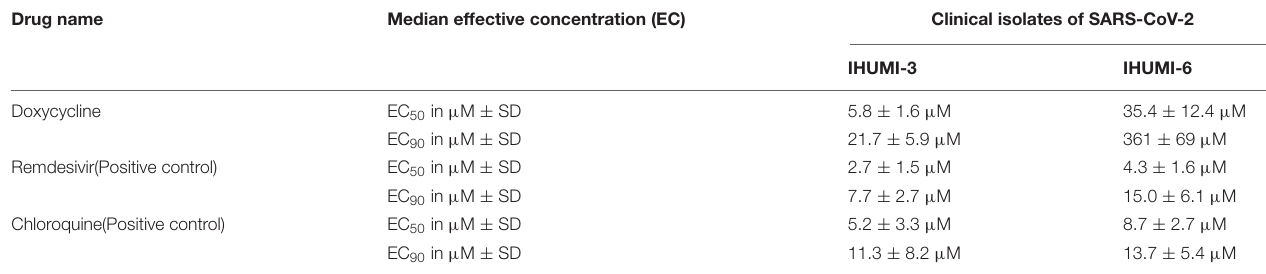
TABLE 3 | In vitro antiviral activity of tested antibacterial drugs against the clinical isolates of SARS-CoV-2. Drug name